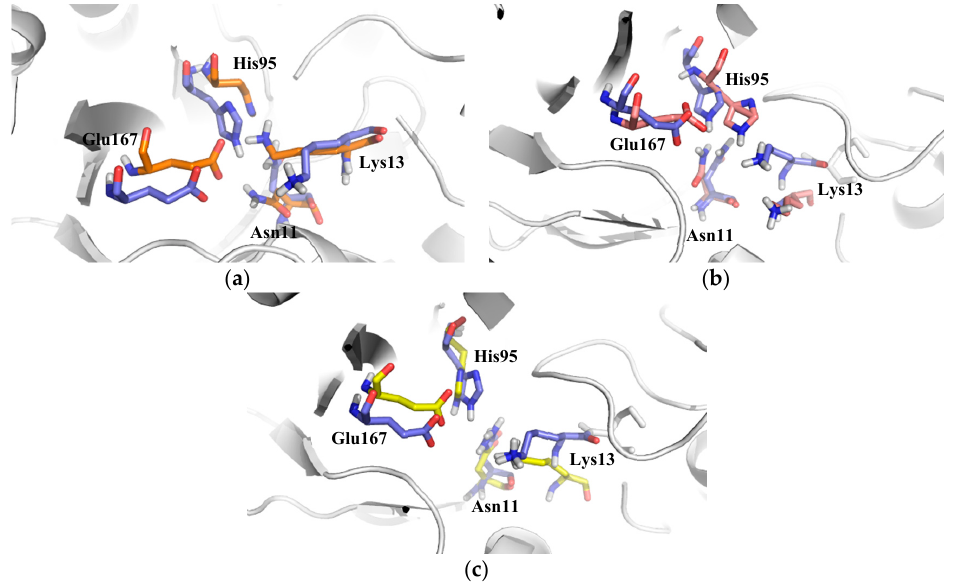
Figure 9. Movement of side chains from catalytic site residues in the Apo-TbTIM (blue sticks) and in complex with ( a ) compound 1 ; ( b ) compound 2 ; and ( c ) compound 3 .